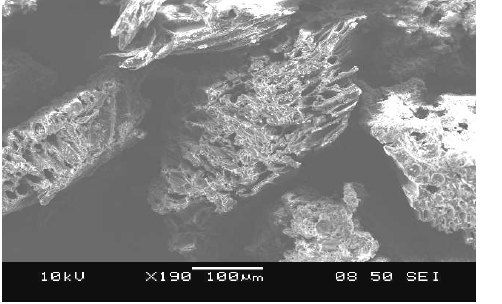
Figure 1. SEM photograph of the RCP